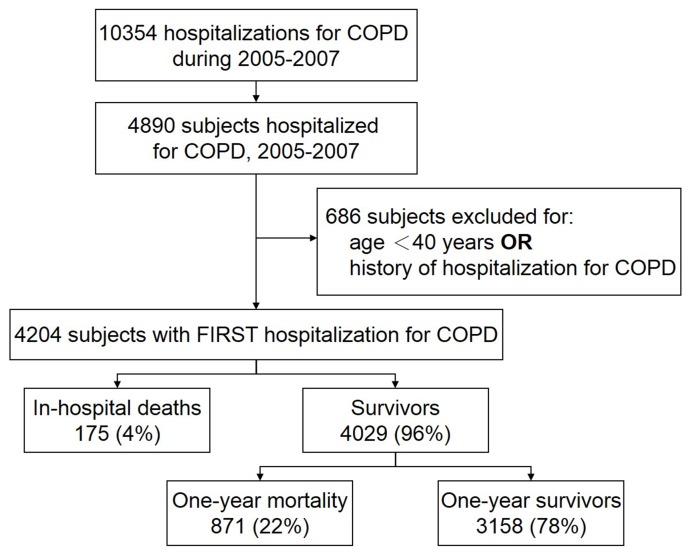
Study flow diagram and main outcomes. COPD, chronic obstructive pulmonary disease.